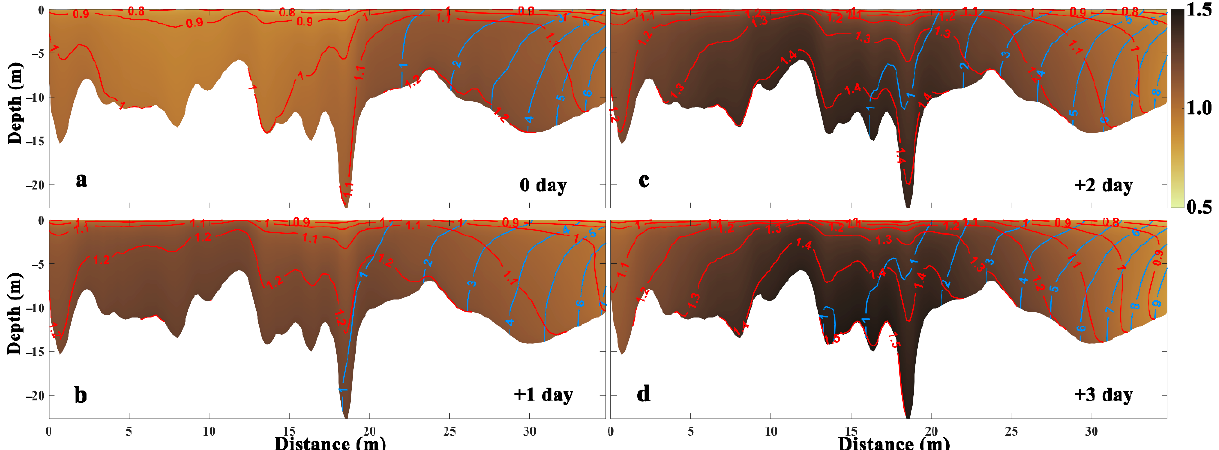
Figure 15. Tidally averaged SSC (red lines and filled contour, unit: kg·m − 3 ) and salinity (blue lines, unit: PSU) distribution on the along-channel section during spring tide with the 5000 m 3 ·s − 1 peak discharge PRD when the river SSC is set to 0.4 kg·m − 3 (Run 12), and the tidal cycle is ( a ) the last during PRD, ( b ) a day later than ( a ), ( c ) two days later than ( a ), and ( d ) three days later than ( a ). The SSC is in 0.1 kg·m − 3 intervals, and the salinity is in 1-PSU intervals.